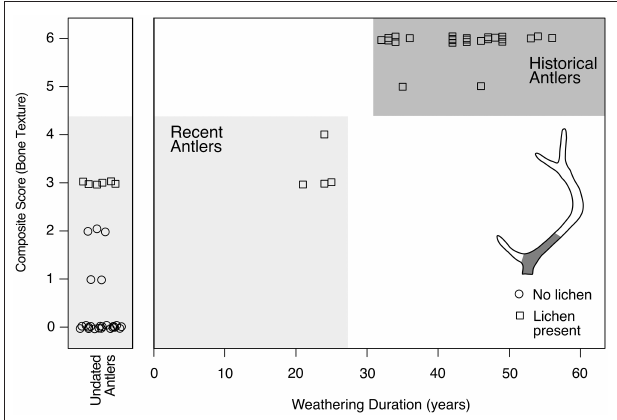
FIGURE 3 | Composite Scores of original bone texture calibrated to weathering duration. Weathering durations are calculated as the antler collection date minus the calibrated AMS date. Composite Scores range from 0 (super-majority of original bone textures preserved) to 6 (no original bone textures preserved). Composite Scores focus on the preservation of original surface textures of antlers. Composite Scores 0–5 characterize antlers in Weathering Stages 0 and 1 ( Behrensmeyer, 1978). Antlers were evaluated along the proximal portion of the main beam (shaded area of antler schematic). Lichen presence or absence (squares or circles) is also